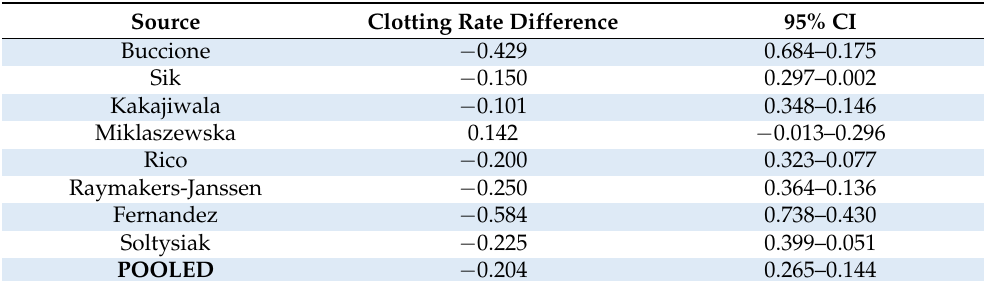
Table 4. Pooled estimate of filter clotting risk for regional citrate anticoagulation vs. heparin